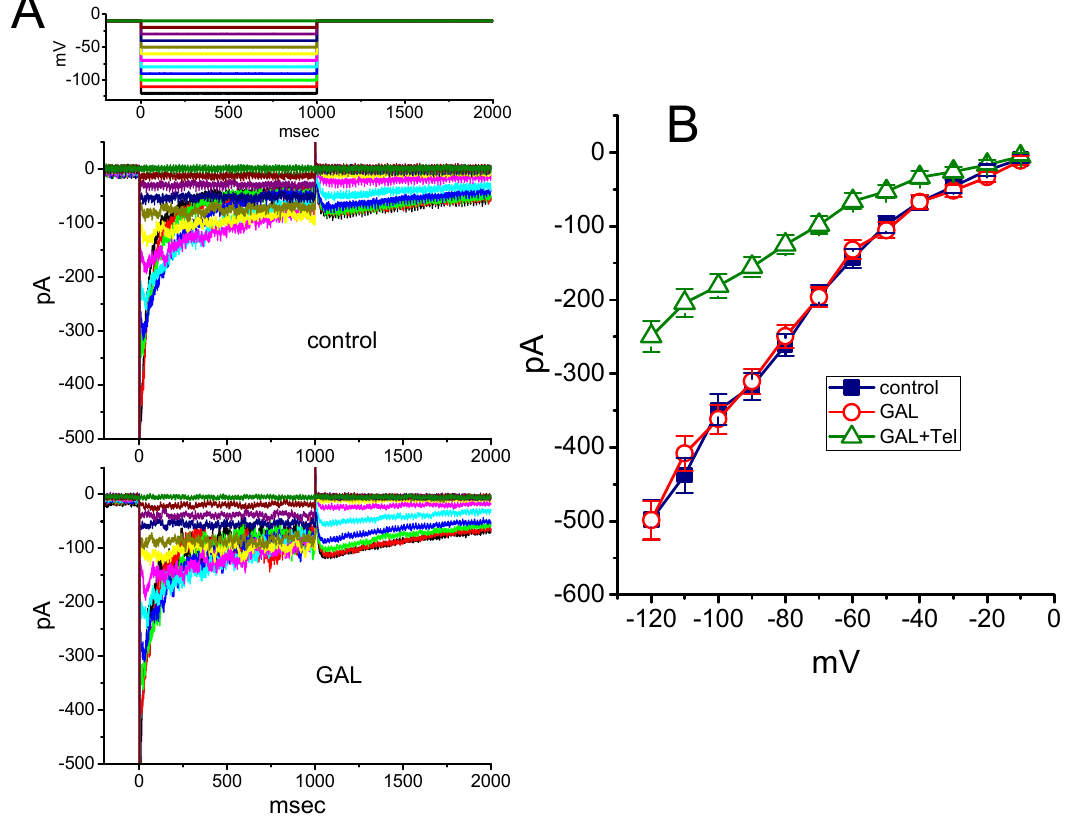
Figure 8. Inability of GAL-021 to suppress erg -mediated K + current ( I K(erg) ) obtained in GH 3 cells. We bathed cells in high-K + , Ca 2+ -free solution and the pipette used was filled with K + -containing solution. ( A ) Superimposed I K(erg) traces in the control (upper) and during the exposure to 10 µ M GAL-021 (lower). The I K(erg) was activated by a series of long-step voltage pulse indicated in the uppermost part of (A). ( B ) Averaged I-V relationship of deactivating I K(erg) in the absence and presence of GAL-021 (10 µ M) or GAL-021 (10 µ M) plus telmisartan (Tel, 10 µ M). Current amplitude was measured at the beginning of each hyperpolarizing voltage step. Each data point represents the mean ± SEM ( n = 7 to 8). Note that GAL at a concentration of 10 µ M was unable to suppress I K(erg) in these